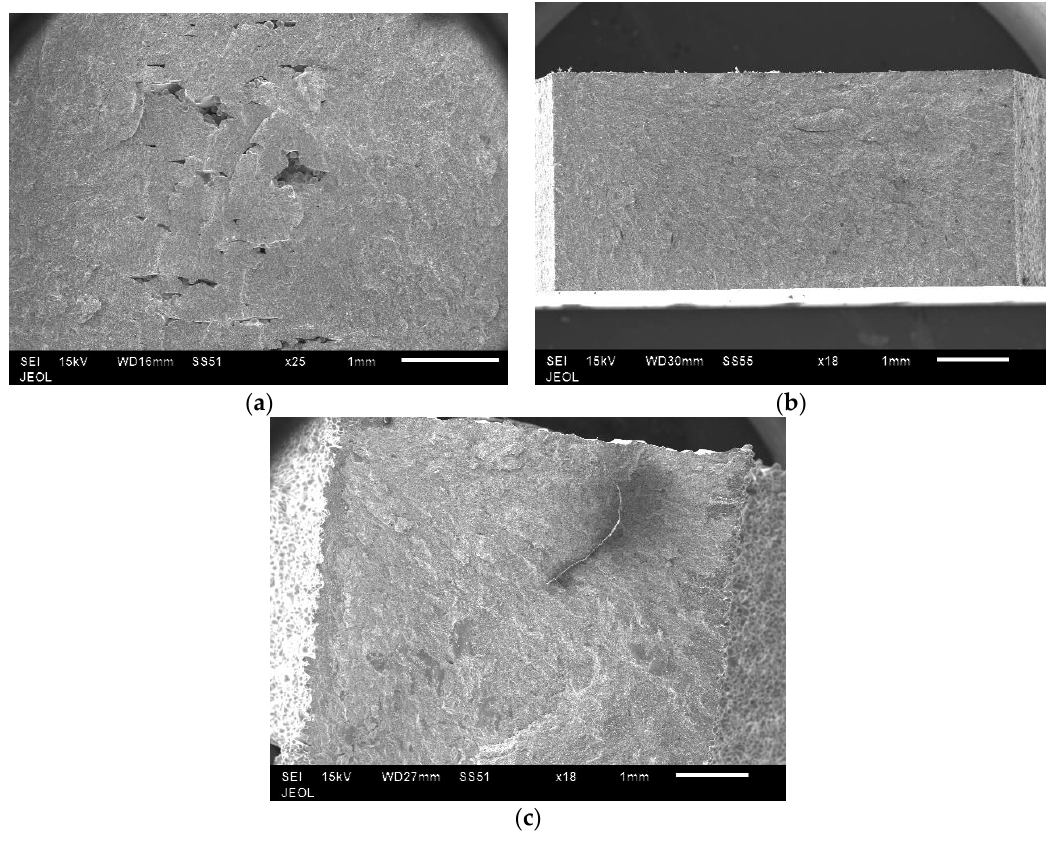
Figure 15. Lack of bonding between layers seen on the tensile fracture surfaces of low energy samples ( a ). These defects were absent in the samples produced using medium ( b ) and high ( c ) energy input.